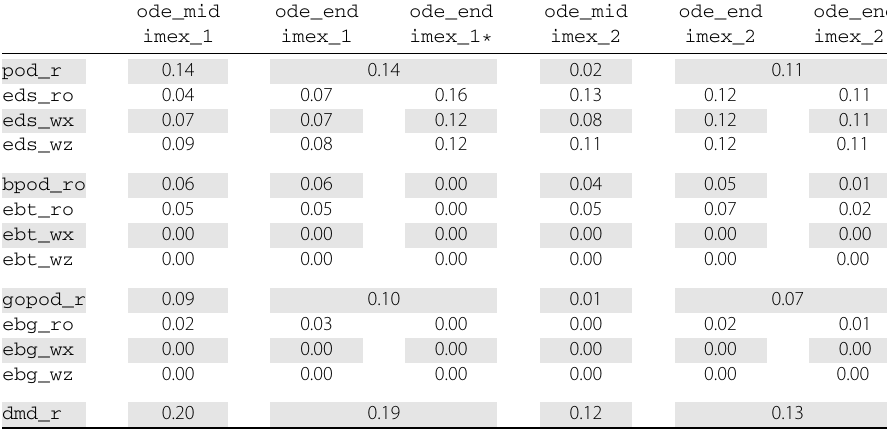
Table 7 MOR SCORE s μ (250, (cid:16) mach(16) ) in the L 2 ⊗ L 2 error norm for the “GasLib-134v2” benchmark network from Sect. 6.4; * notes linear